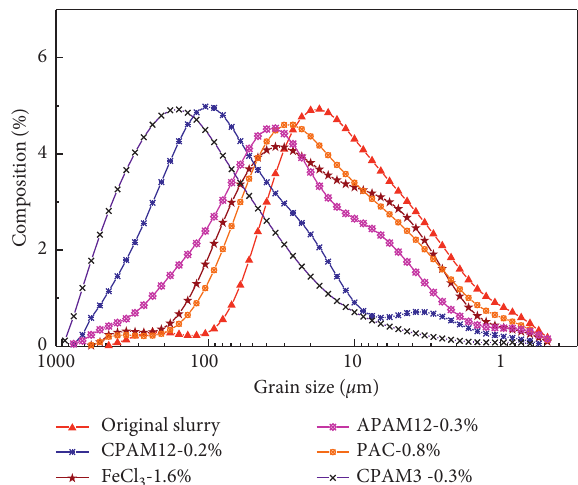
Figure 9: Zeta potential curve of slurry with different flocculant dosages (1, 2, 3, 4, and 5 correspond to the different dosages in Table 2, and 0 refers to no flocculant addition. The point marked by red circle refers to the zeta potential corresponding to the optimal dosage of each